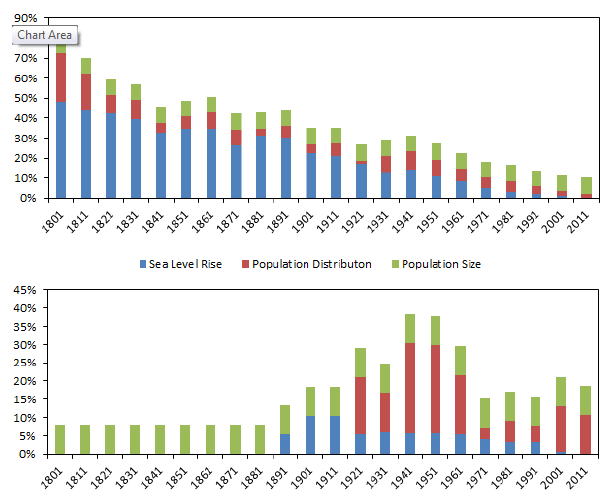
Figure A2. Quantification of the sources of uncertainty within the methodology for Portsea (above) and Hayling